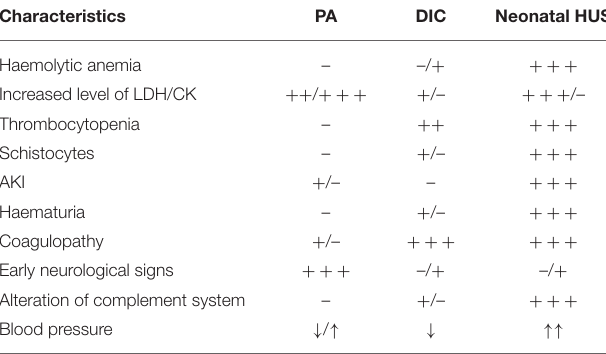
TABLE 1 | Elements to help in the differential diagnosis between perinatal asphyxia (PA), disseminated intravascular coagulation (DIC), and neonatal hemolytic uremic syndrome